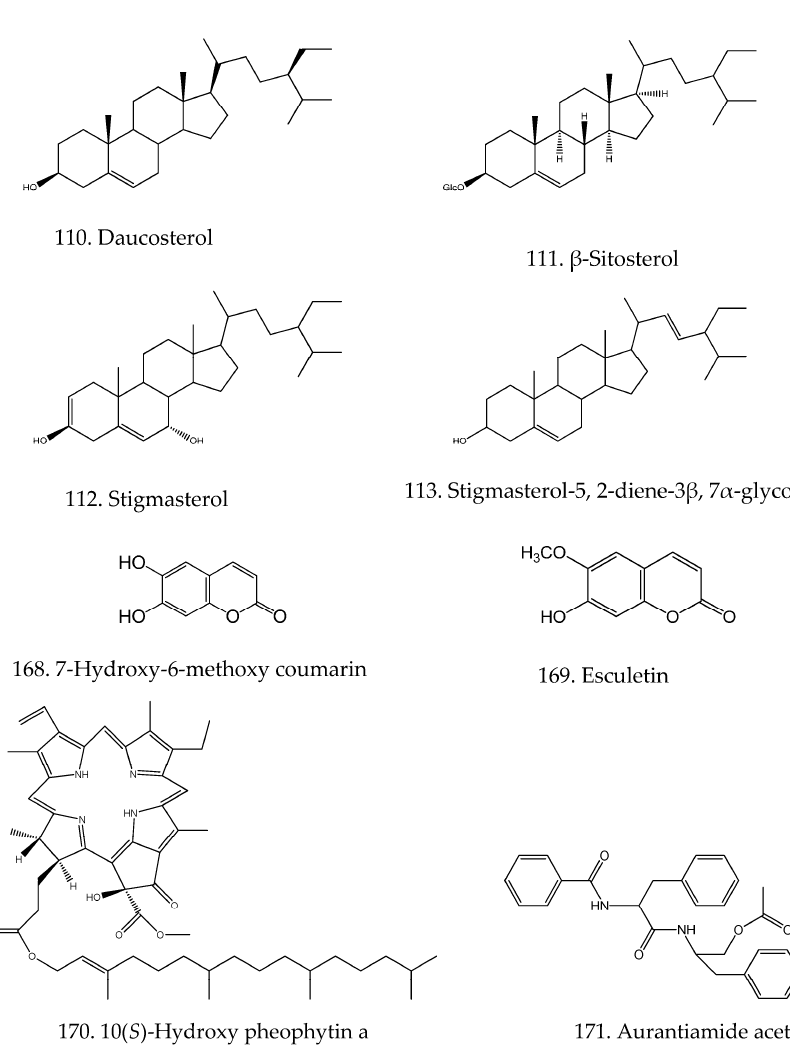
Figure 5. Chemical structures of miscellaneous components in H. diffusa.